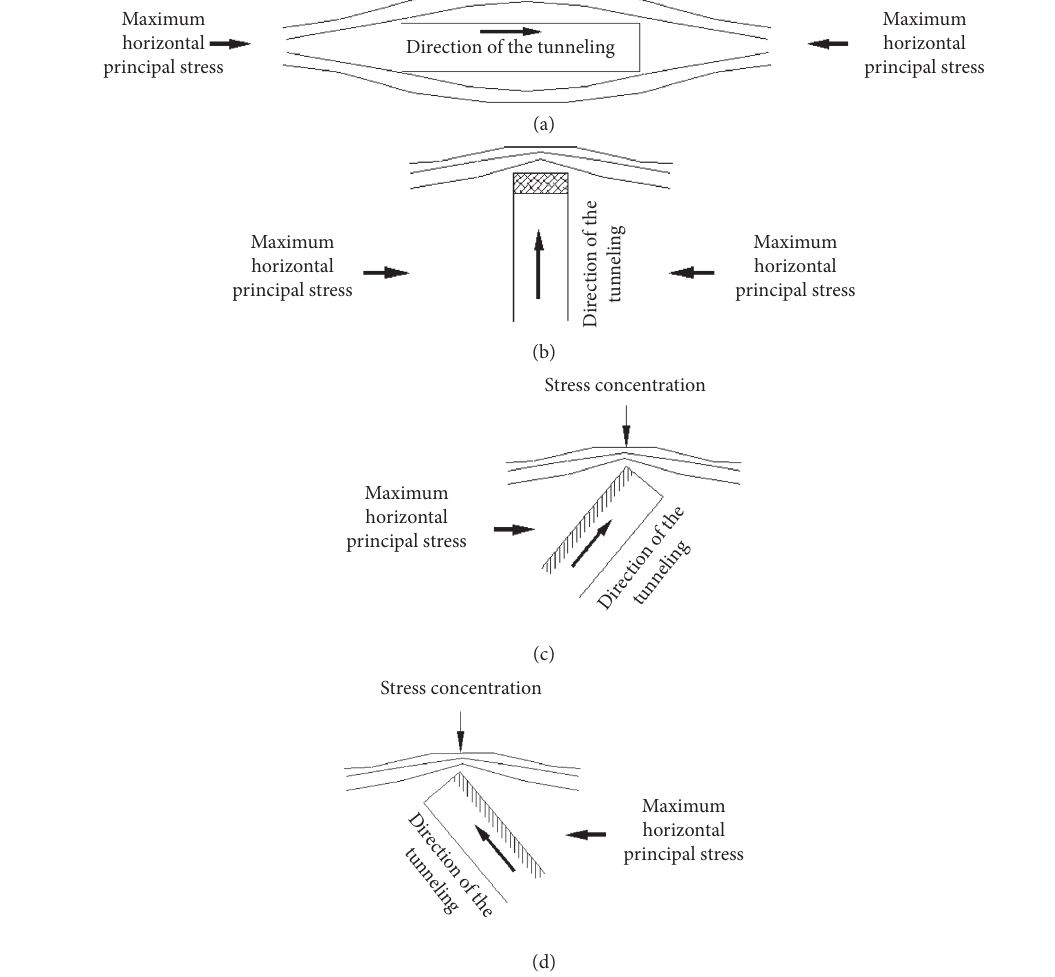
Figure 7: Difference of roadway conditions in different heading directions (plan). (a) Good roadway condition. (b) Poor roadway condition. (c) Deformation occurred on the left side of the roadway. (d) Deformation occurred on the right side of the